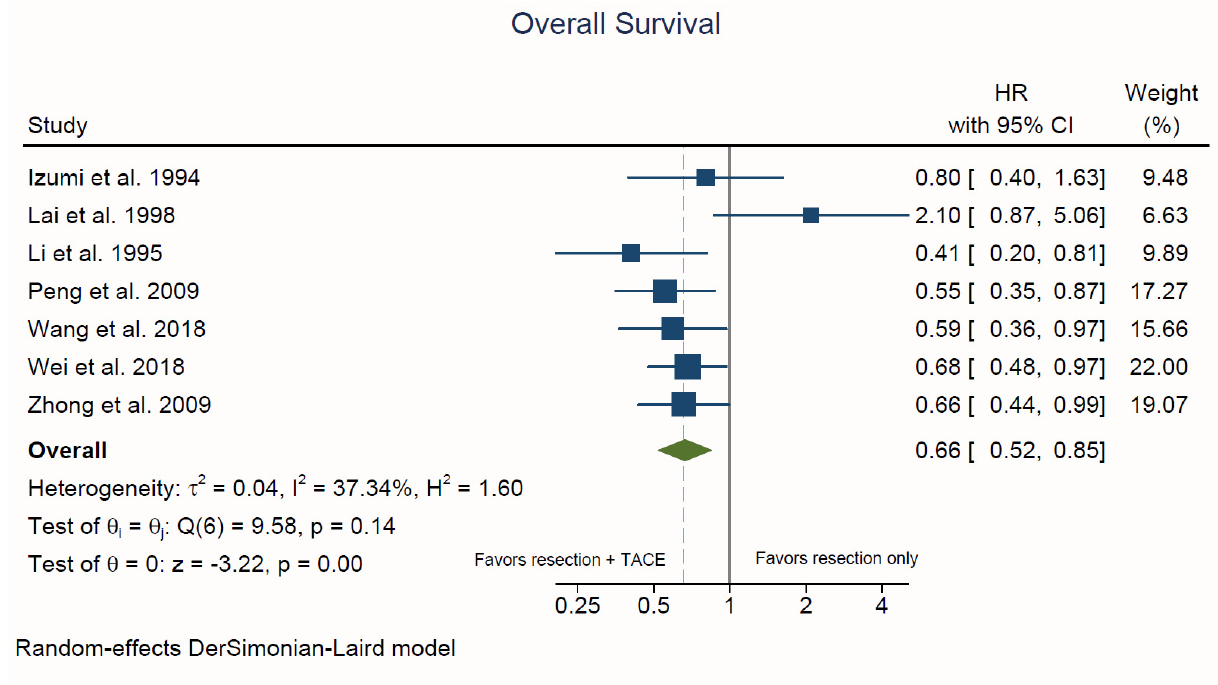
Figure 3. Forest plot of overall survival. HR: hazard ratio; CI: confidence interval.